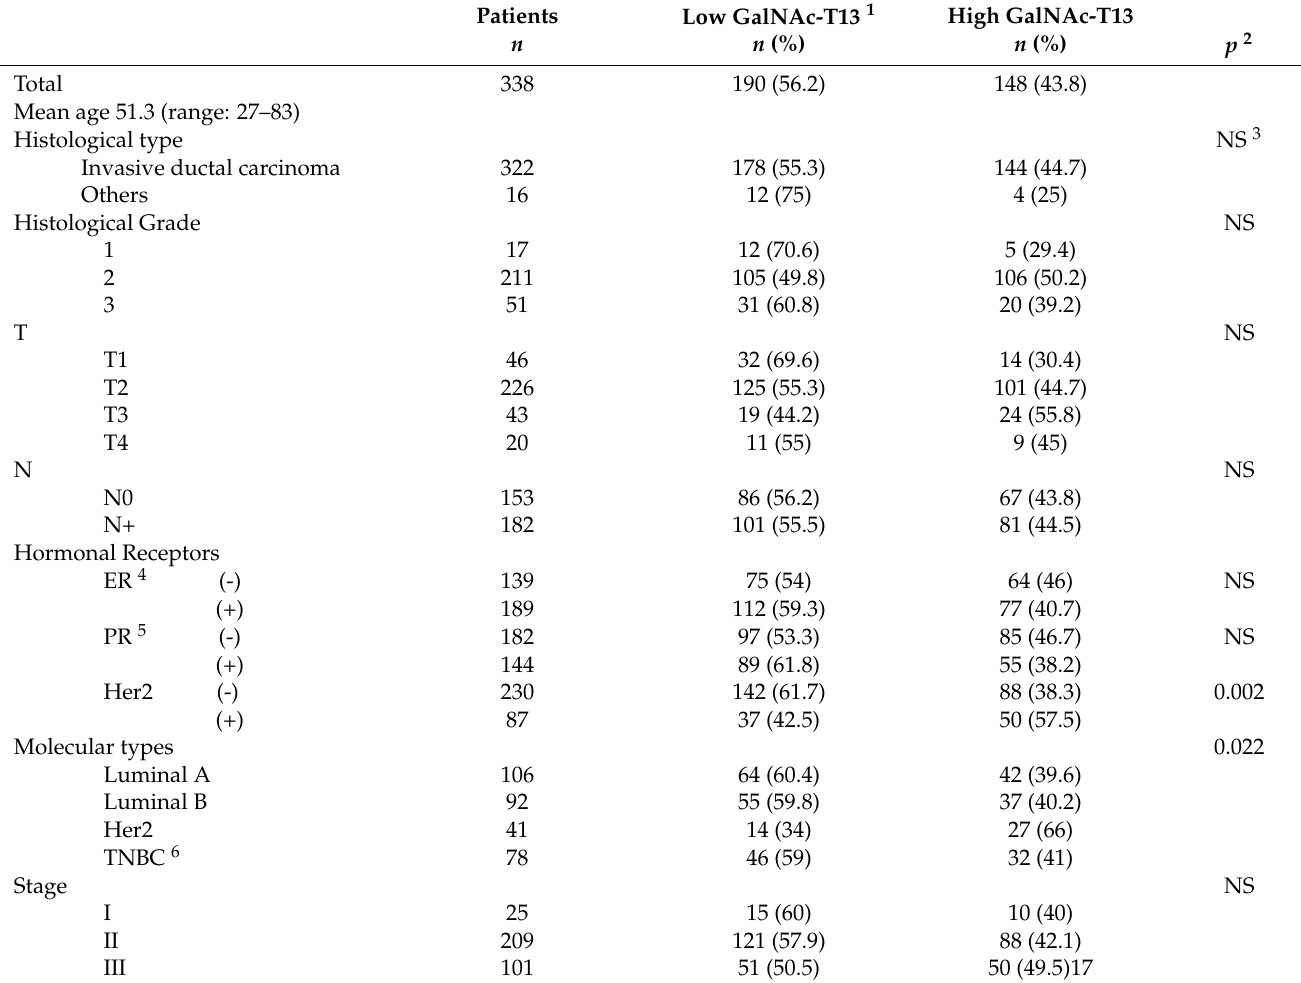
Table 1. Correlation of GalNAc-T13 expression with the clinical features of the